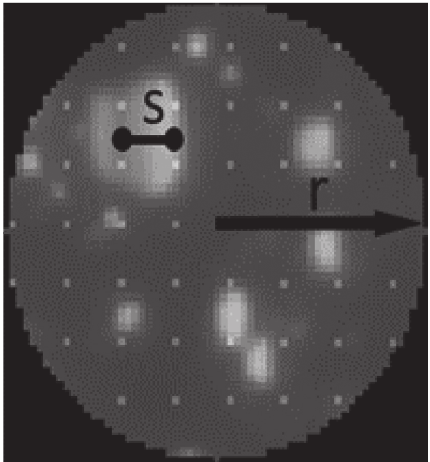
Figure 4: Subset spacing and subset